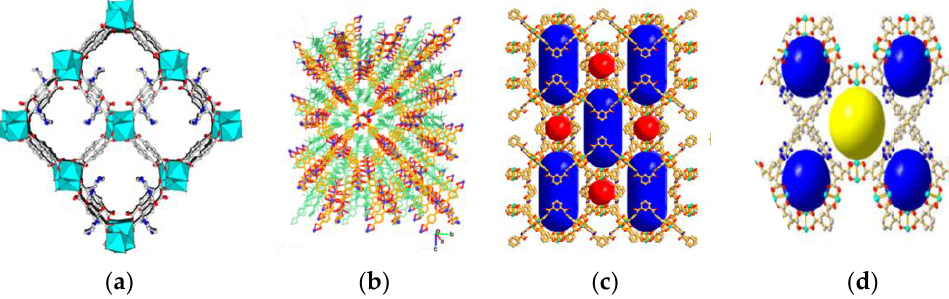
· 3H 2 (OH)(btc)(Hbtc) 0.4 (L) 0.6 2 O (reprinted with